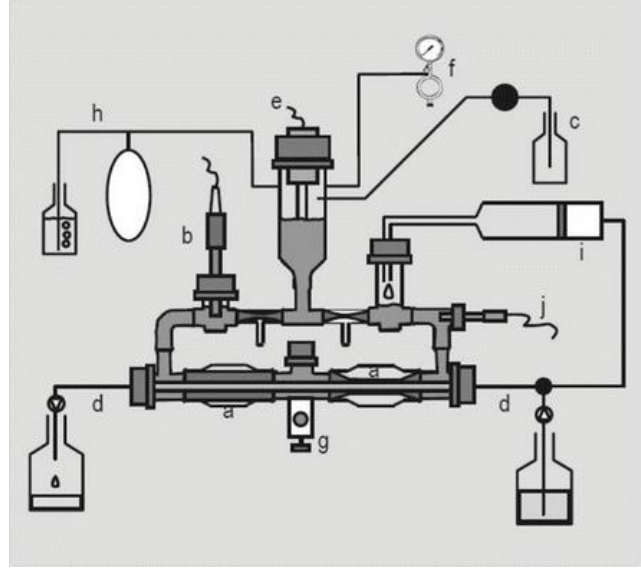
Figure 10. Schematic overview of the Netherlands Organization for Applied Scientific Research (TNO) in vitro model of the colon (TIM-2). (a) peristaltic compartments containing fecal matter; (b) pH electrode; (c) alkali pump; (d) dialysis liquid circuit with hollow fibre membrane; (e) level sensor; (f) N 2 gas inlet; (g) sampling port; (h) gas outlet; (i) ‘ileal efflux’ container; (j) temperature sensor. Adopted from [5] , SpringerLink, 2015.